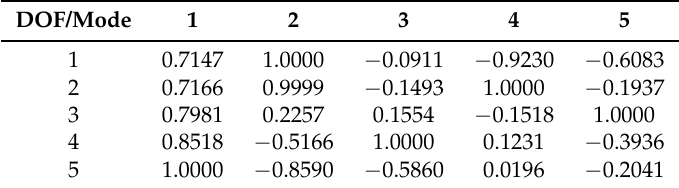
Table 3. Real modes of the five-DOF